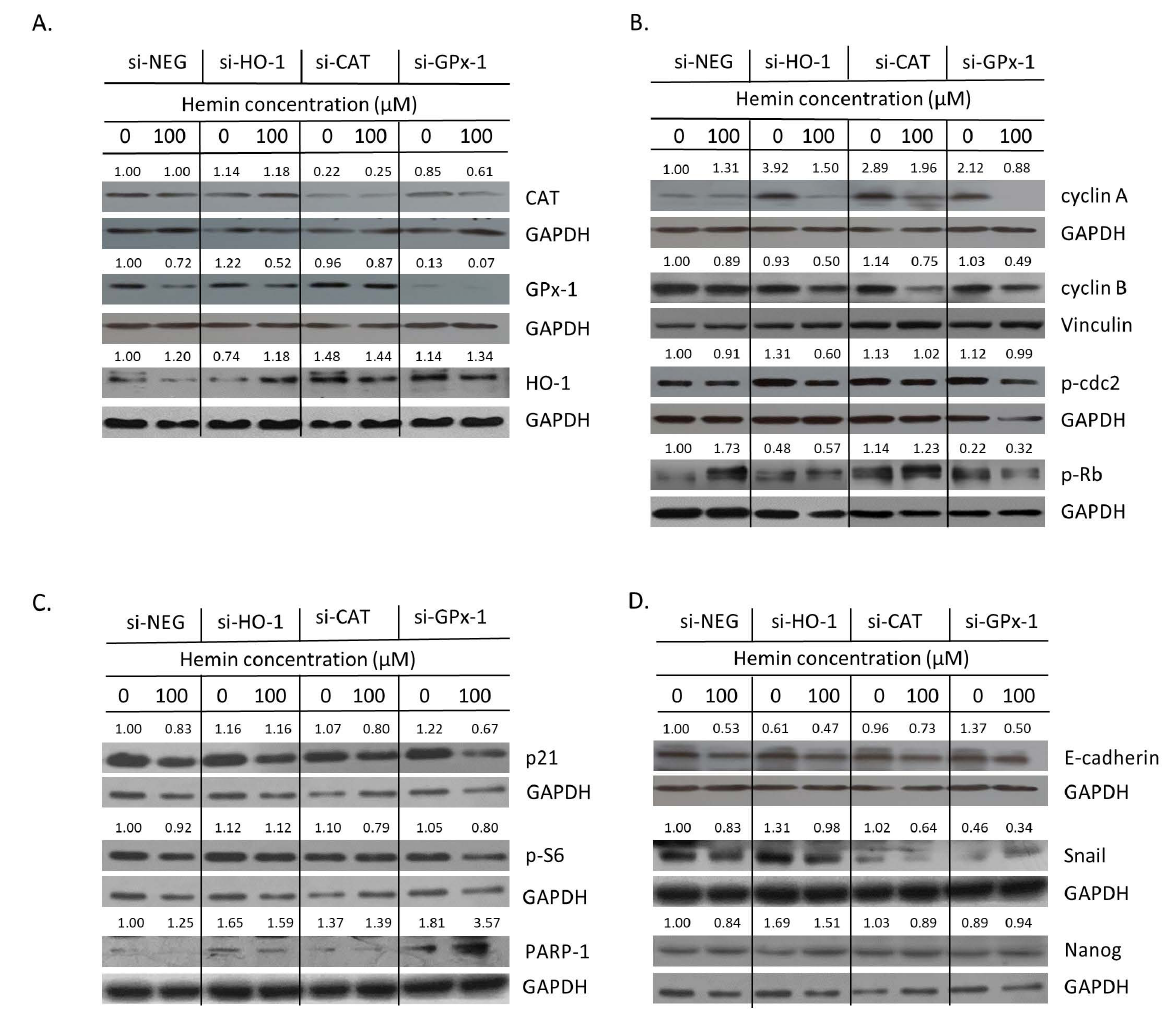
Figure 7. Silencing of antioxidative enzymes maintains colon cancer cells in a senescent state: changed expression of proteins related to proliferation and EMT. In HCT116 cells, genes encoding antioxidative enzymes—HO-1, CAT, and GPx-1—were silenced with the use of siRNAs. Cells were exposed to IRINO and 100 µ M hemin ( (cid:3) ). Control cells were subjected to IRINO and NaOH treatment ( (cid:4) ). Cells were incubated with drugs for 24 h, then cultured in a drug-free medium for 4 days. ( A ) Expression of antioxidative enzymes. Representative blots show levels of catalase, GPx-1, and HO-1 proteins. ( B ) Expression of proteins related to cell cycle progression. Representative blots show levels of cyclin A, cyclin B, p-cdc2, and p-Rb. ( C ) Expression of proteins related to cell cycle inhibition, geroconversion, and tumor suppression. Representative blots show levels of p21, p-S6, and p53 proteins. ( D ) Expression of proteins related to EMT and stemness. Representative blots show levels of E-cadherin, Snail, and Nanog. GAPDH or vinculin acts as a loading